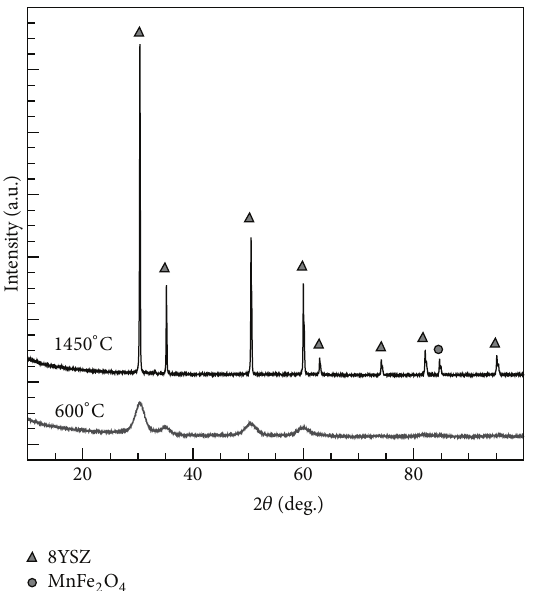
Figure 1: Precalcination (600 ∘ C) and postcalcination (1450 ∘ C) XRD for sol-gel derived MnFe 2 O 4 in 8YSZ.